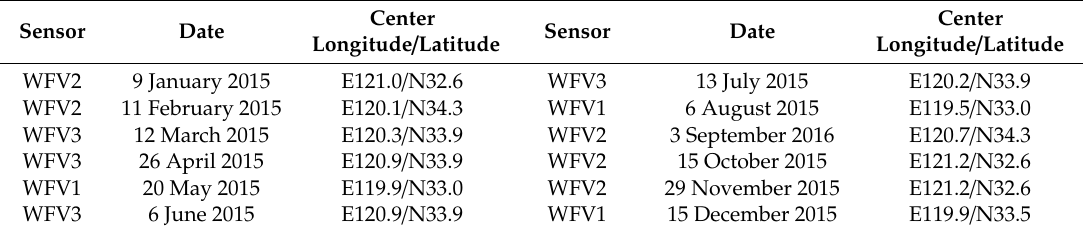
Table 1. The detailed information of the GF-1 WFV data used in this